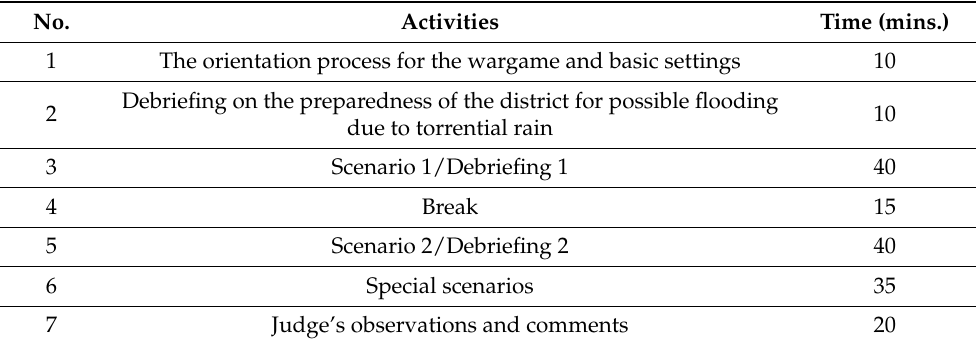
Table 2. Time slot of flooding wargame conducted for Yonghe District. No. Activities Time (mins.)